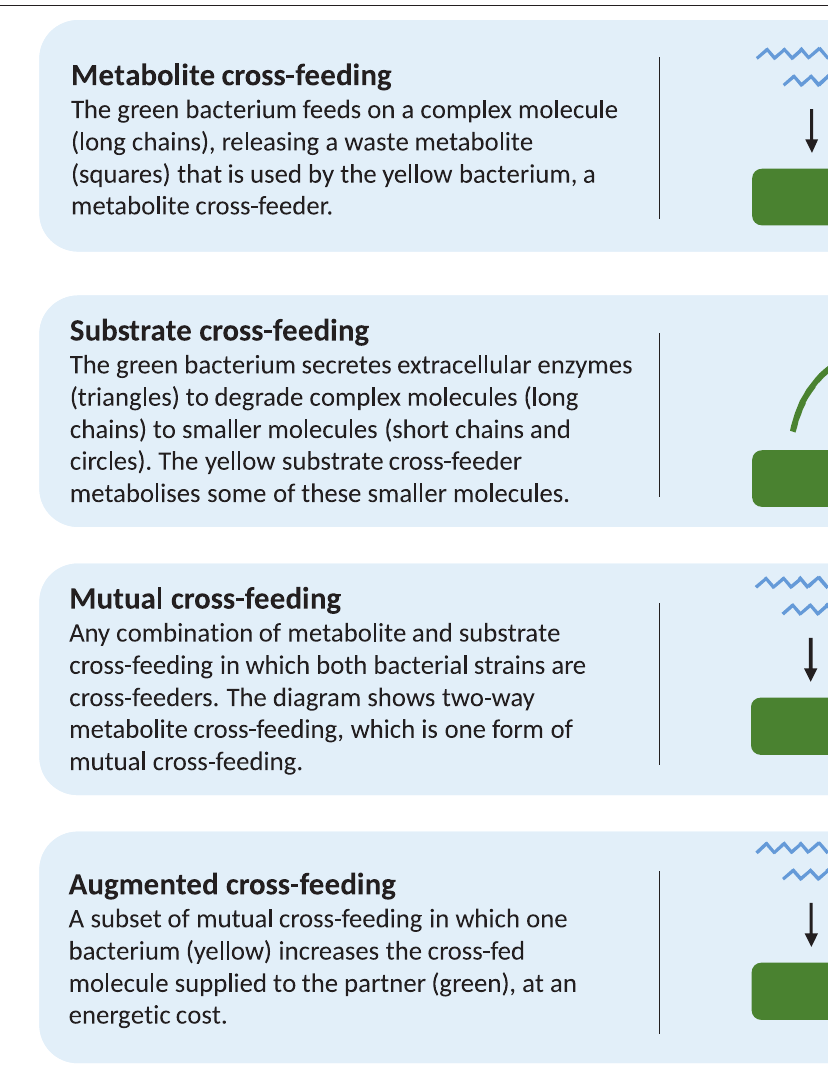
et al., 2017). Separately, Lactobacillus acidophilus , when